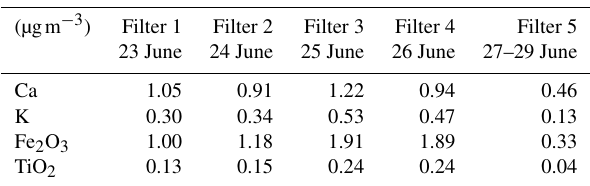
Table 3. Concentration of Ca, K, Fe 2 O 3 and Fe 2 O 3 during the pe- riod 23–29